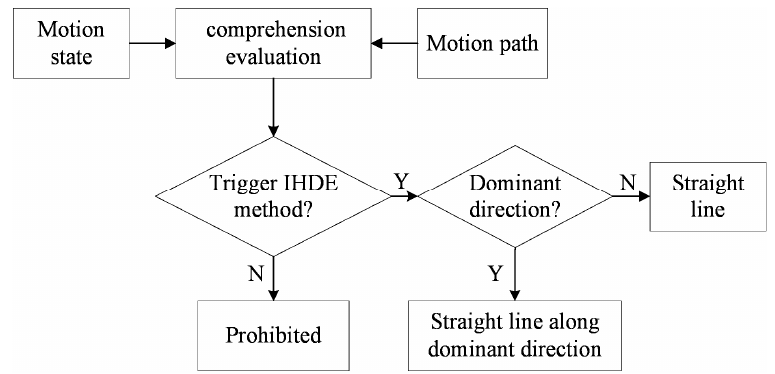
Figure 5. The block diagram of the proposed method.